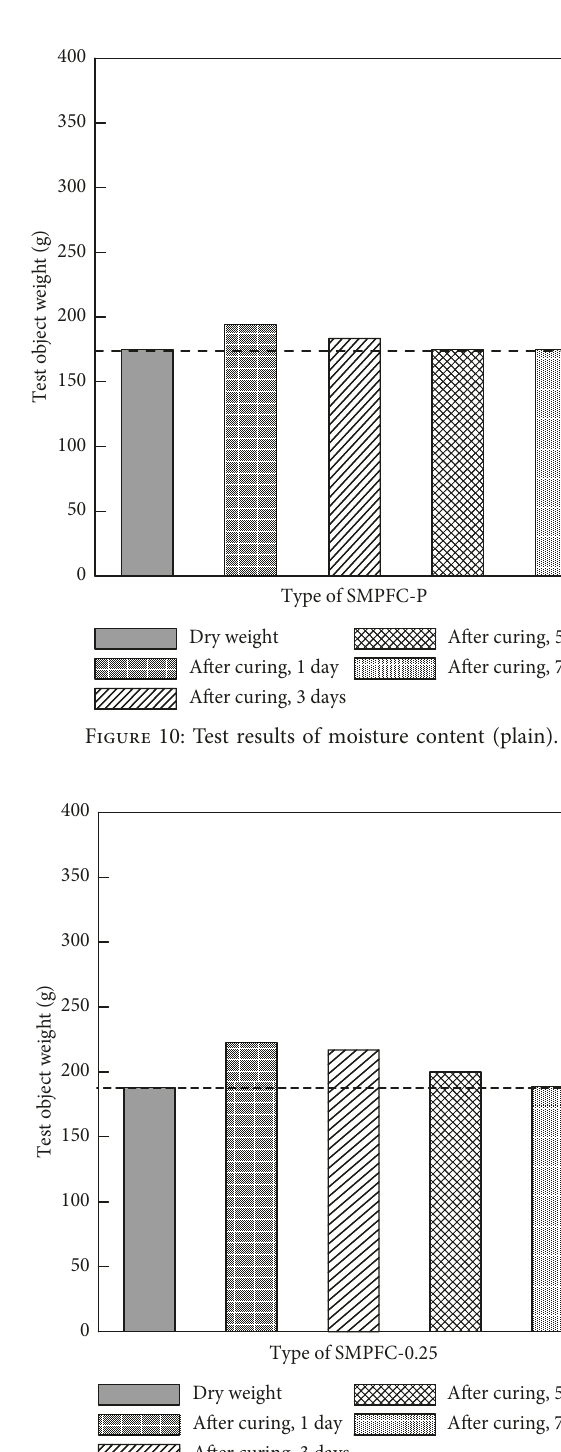
Figure 11: Test results of moisture content (SAP 0.25%).